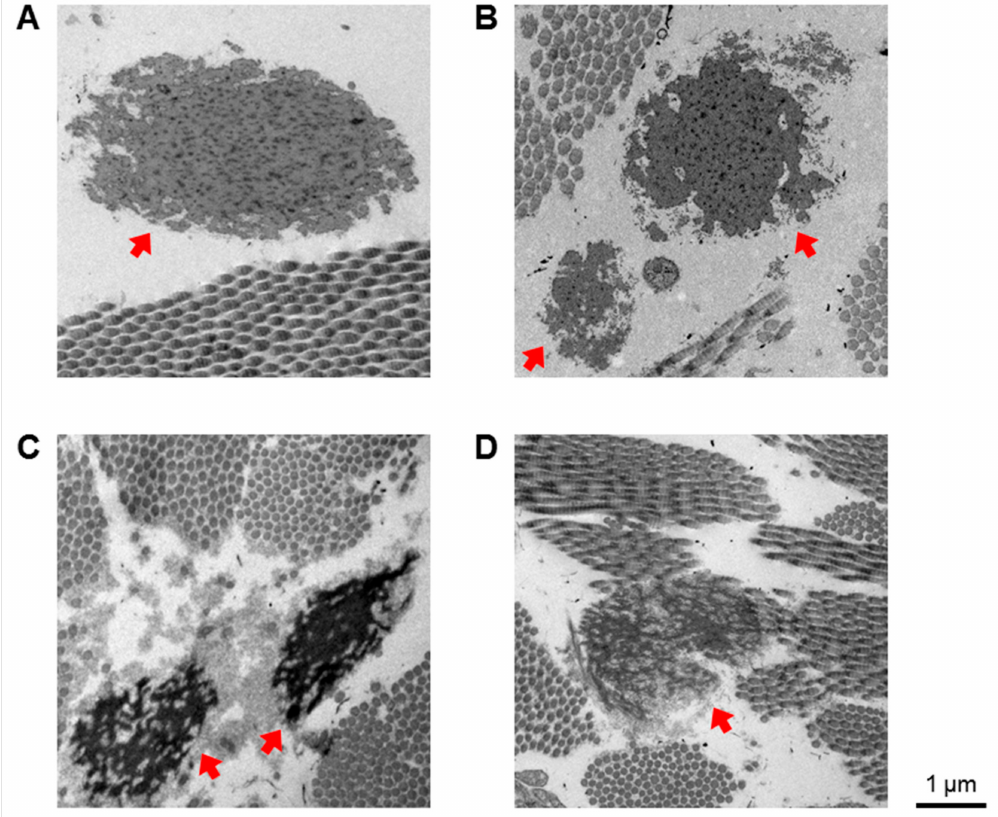
Figure 6. Electron micrographs of skin biopsies from ( A ) a healthy control, ( B ) a PLOD1 -kEDS patient and ( C , D ) two unrelated FKBP14 -kEDS patients. Elastic fibers are indicated by red arrows. Electron micrographs were taken at the Center for Microscopy and Image Analysis, University of Zurich with a Philips CM 100, a 100 KV transmission electron microscope equipped with a digital charge-coupled device (CCD) camera for image